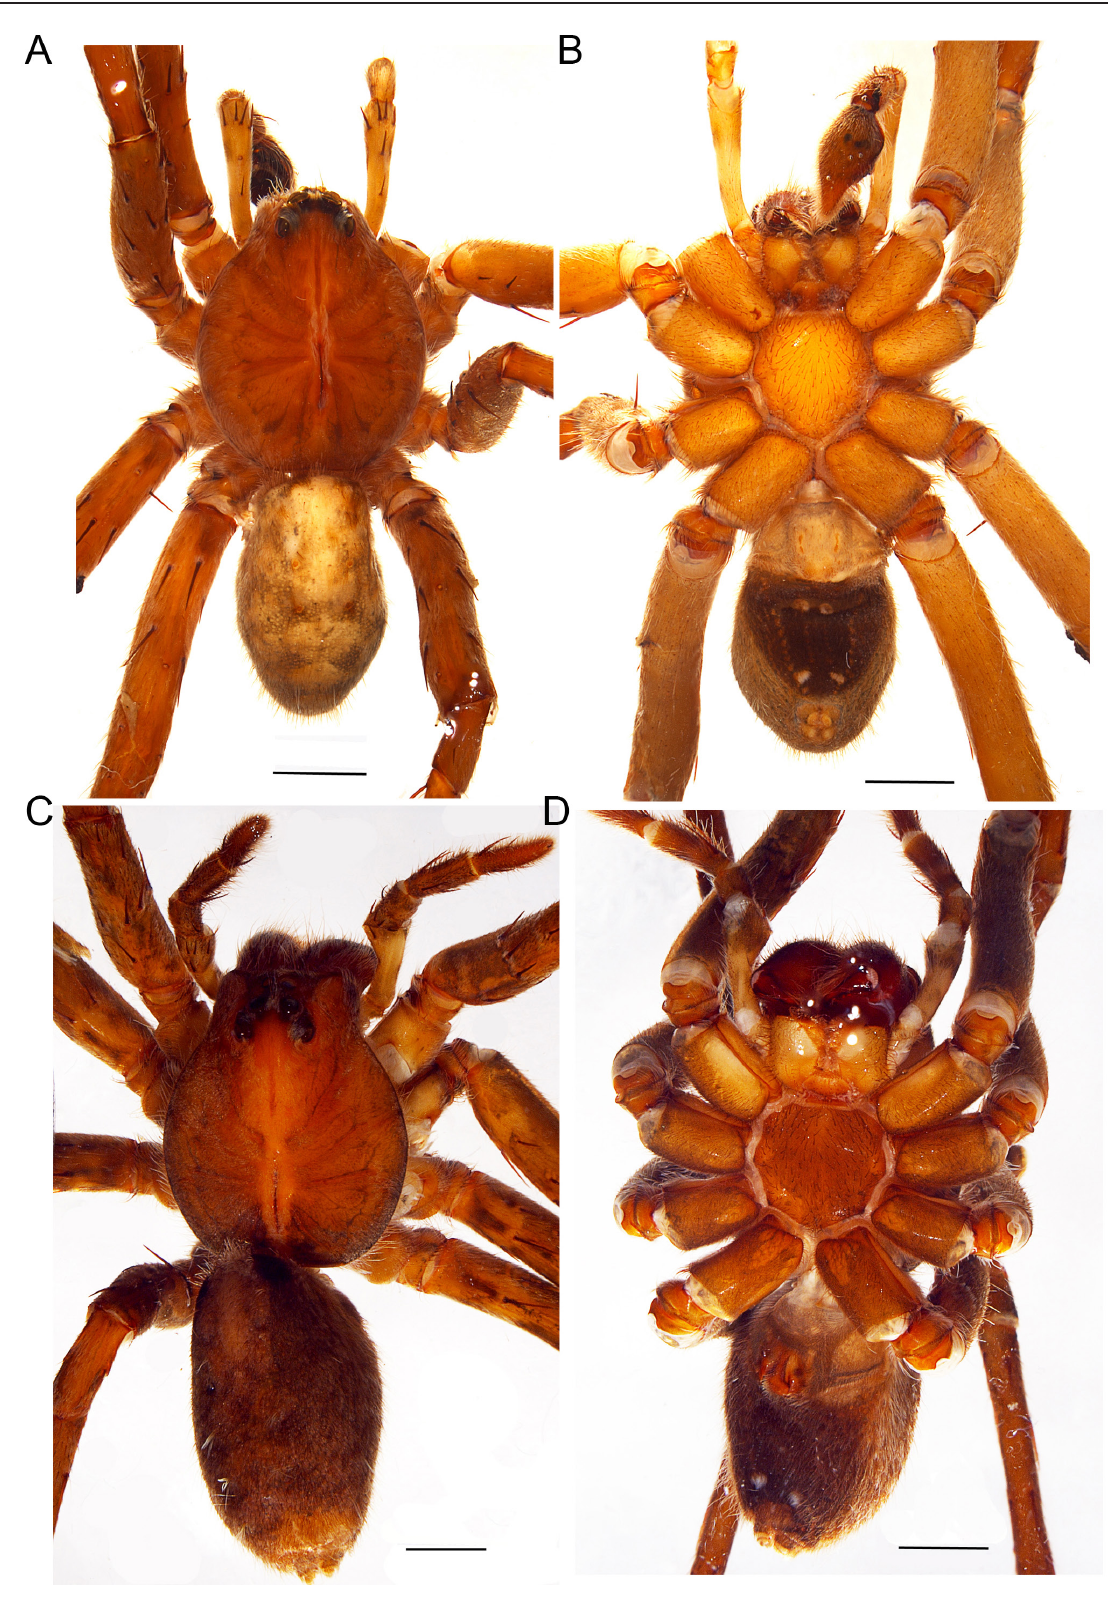
Fig. 4. Afroneutria immortalis (Arts, 1912) comb. nov. Habitus. A . ♂ , dorsal view. B . ♂ , ventral view. C . ♀ , dorsal view. D . ♀ , ventral view. Scale bars = 2